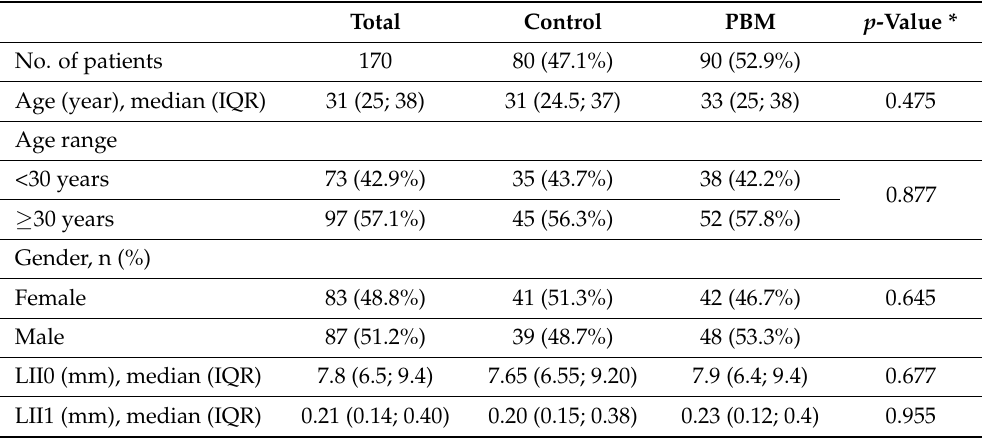
Table 1. Basic demographic and clinical characteristics of the sample.